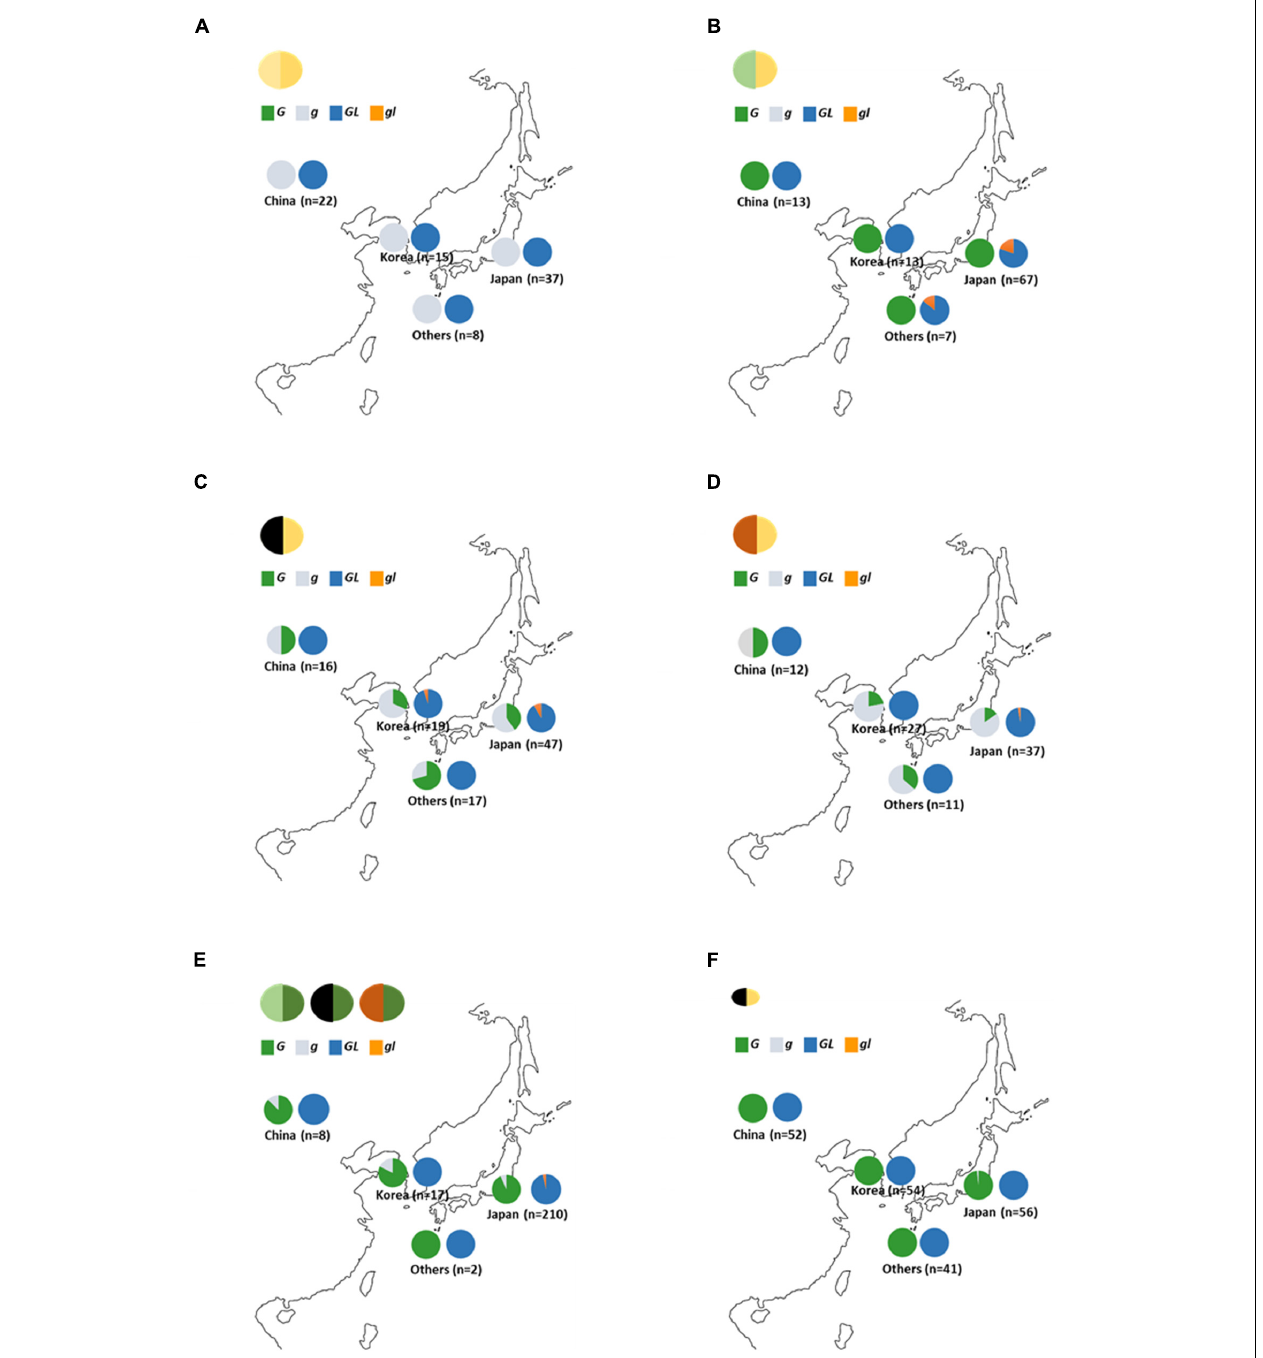
FIGURE 7 | Distribution of G and GL alleles in soybean germplasm. (A) Yellow seed coat soybeans. (B) Green seed coat soybeans. (C) Black seed coat soybeans. (D) Brown seed coat soybeans (E) Green cotyledon soybeans . (F) Wild soybeans. “Others” include soybean germplasm from outside China, Korea, and Japan. Green, gray, navy, and orange in graphs indicate the ratio of the G , g , GL , and gl alleles, respectively.